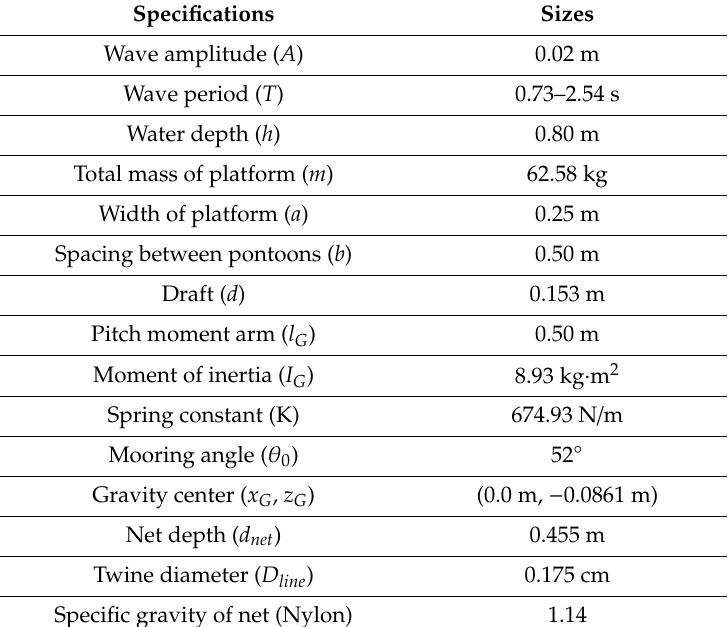
Table 1. Characteristics of the floating platform with a fishnet.